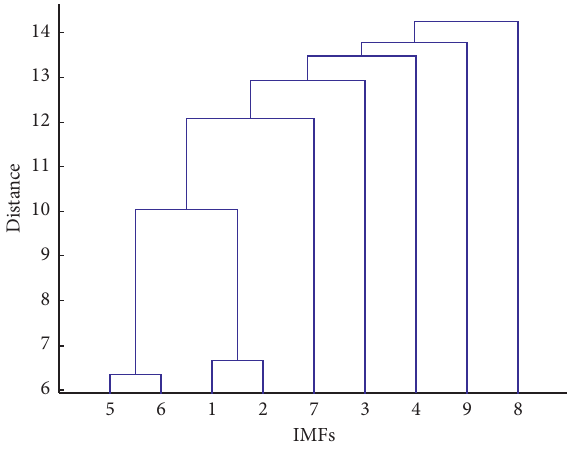
Figure 8: Results of clustering (EEMD). Table 1: Table of effectiveness degree coefficients (improved EEMD).